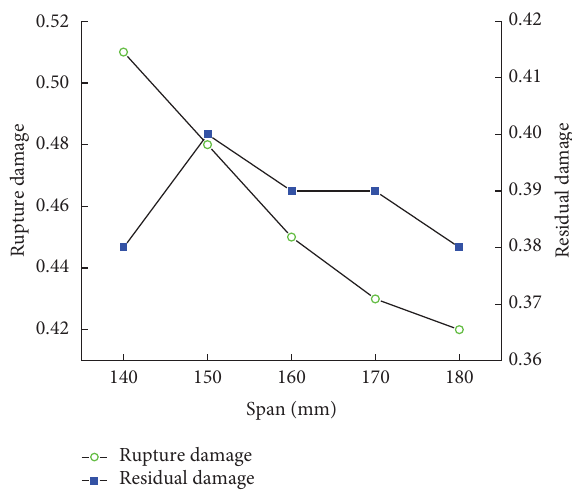
Figure 10: Characteristic analysis of diferent span damage evo- lution